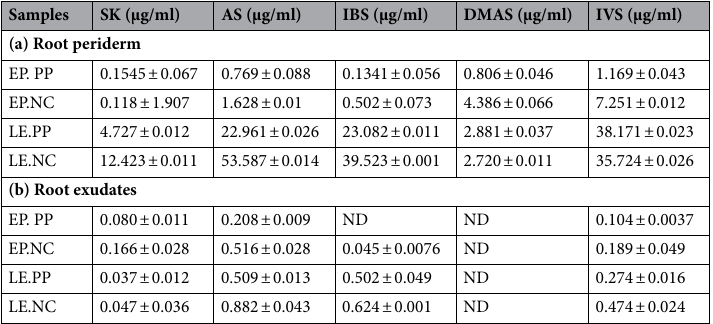
Table 1. Quantitative analysis of shikonin and its derivatives via HPLC in (a) root periderm; (b) root exudates samples of E. plantagineum (EP) and L.erythrorhizon (LE). Each sample is a composite sample of 3–4 individual plants, with three replicates per sample. Data represents mean ± SD of three independent experiments. ND not